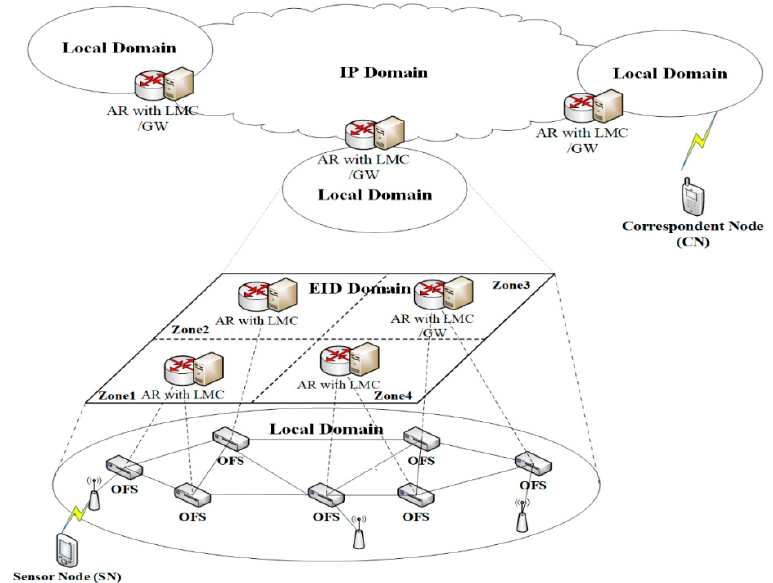
Figure 1. System architecture of the proposed scheme.